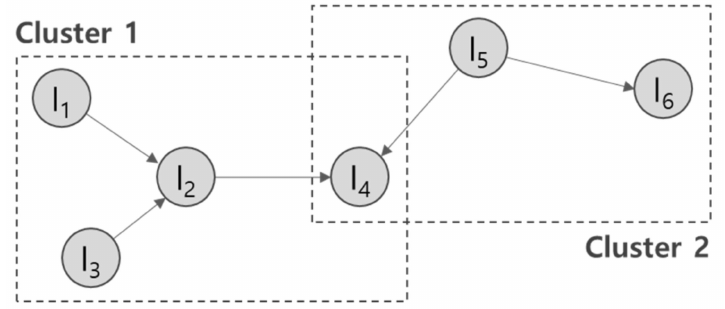
Figure 6. Example of the smart network